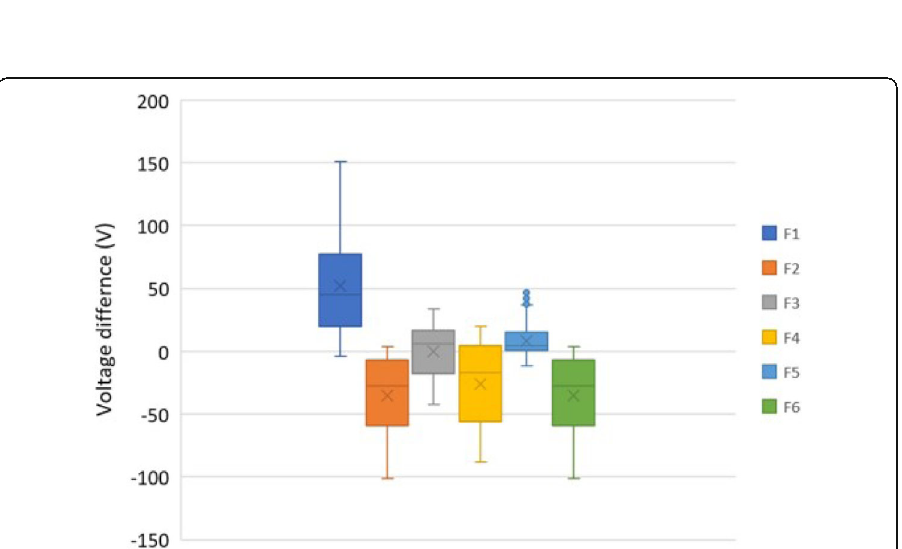
Fig. 6 Voltage difference between the MV nodes and OLTC for each feeder